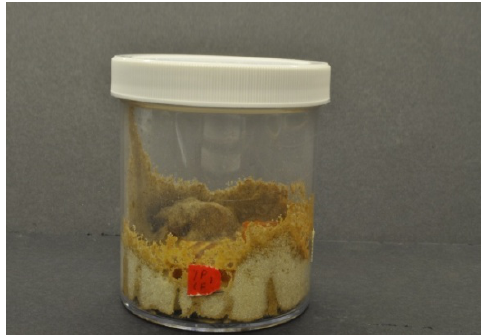
Figure 3. Tunnel network of C. formosanus .